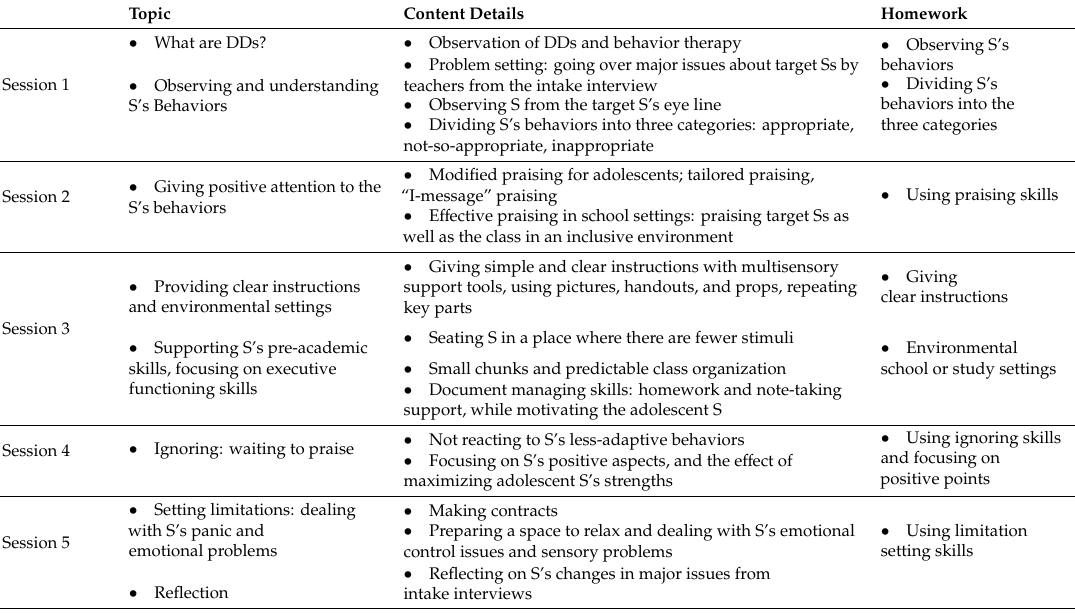
Table 4. Teacher training program content